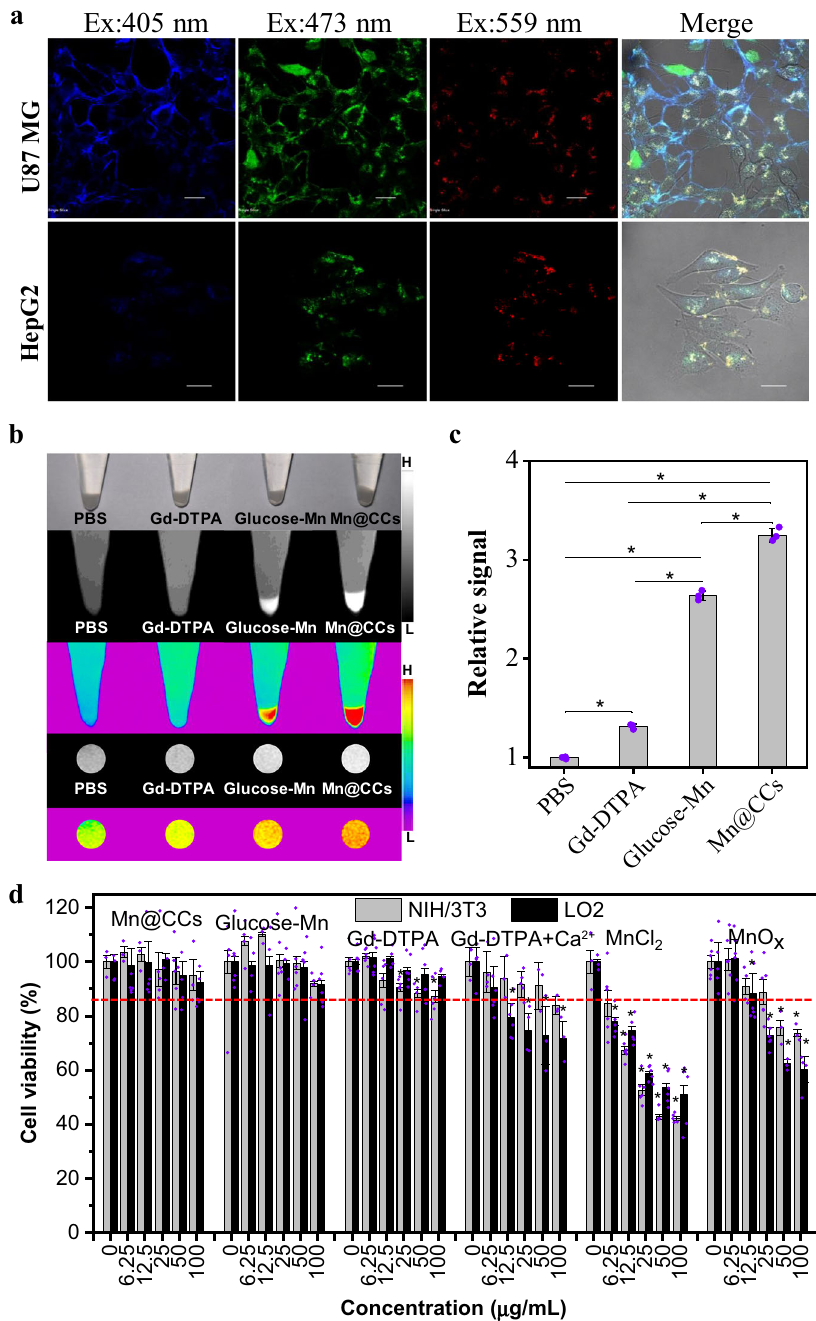
Fig. 3 Gliomas and hepatocyte carcinoma cell lines take up Mn@CCs, and the toxicity assessments of Mn@CCs and other Mn-based agents. a Fluorescent images of U87 MG and HepG2 cell lines pretreated with Mn@CCs for 4 h at 37 °C under excitation of 405, 473, and 559 nm. Experiments were repeated three times. b Photograph and T 1 -weighted MR images of U87MG cells incubated with PBS, Gd-DTPA, Glucose-Mn and Mn@CCs for 3 h. c Relative signal quanti fi cation of U87MG cells incubated with different agents in b ( n = 3 independent experiments). *Signi fi cant differences from the PBS, Gd-DTPA, Glucose-Mn, and Mn@CCs with four group, P < 0.05. d Cell viabilities evaluated of normal cell lines (NIH/3T3 and LO2) incubated